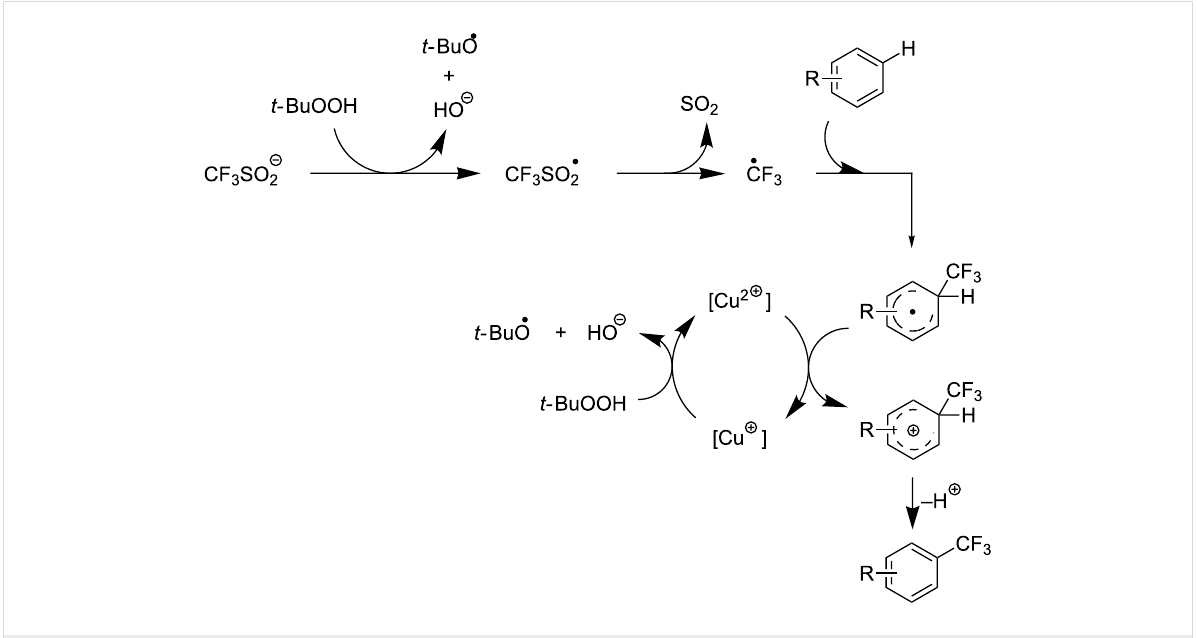
Figure 9: Mechanistic rationale for the trifluoromethylation of arenes in presence of Langlois’s reagent and a copper catalyst (B. R. Langlois et al.) [88].